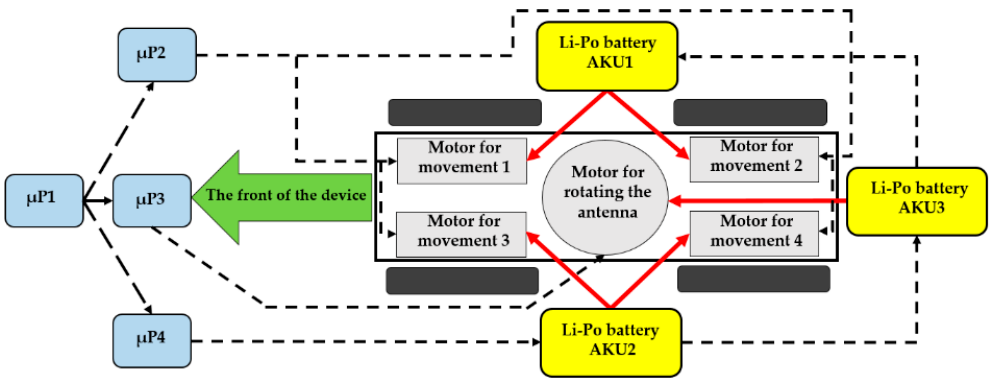
Figure 4. Displaying the monitoring equipment for the accumulators’ capacity.